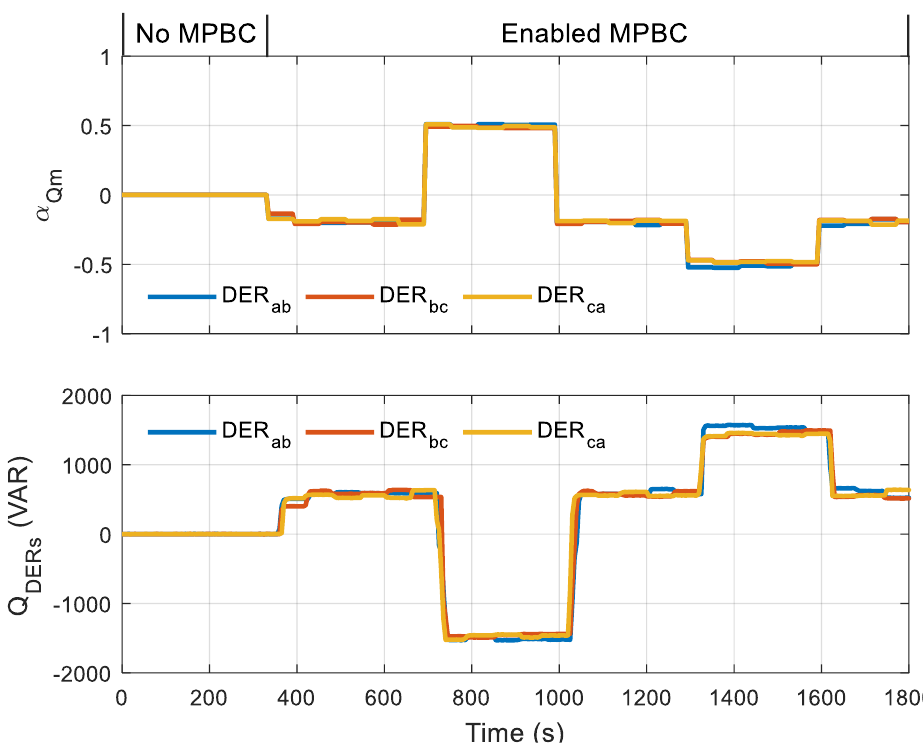
Figure 9. Behavior of coefficients 𝛼 𝑄𝑚 and DER reactive power during GOS mode, in terms of voltage variation.